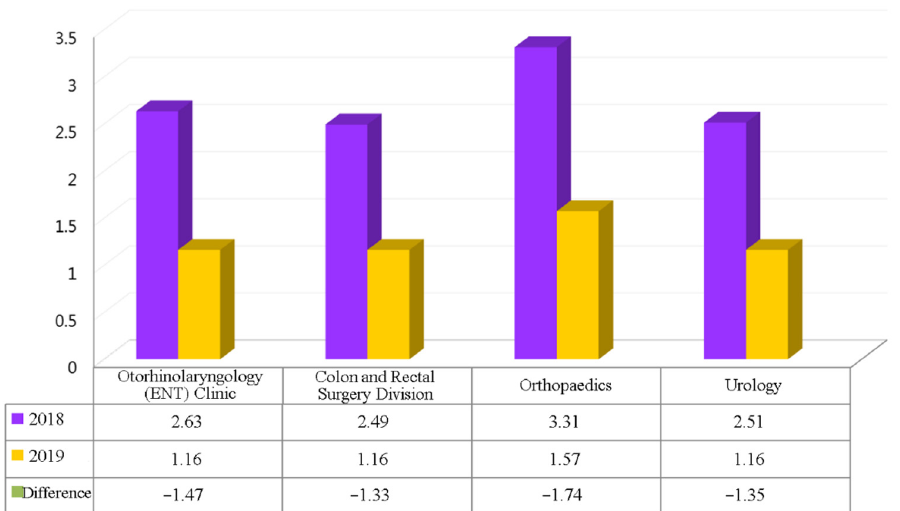
Figure 7. Average length of hospital stay.